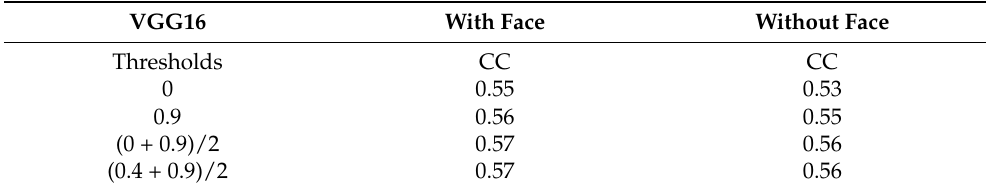
Table 1. The OSIE dataset. Tests with different rarity thresholds, both face and without face features on VGG16.